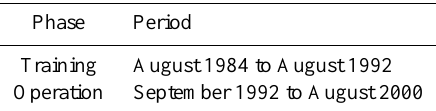
Table 2. Organization of